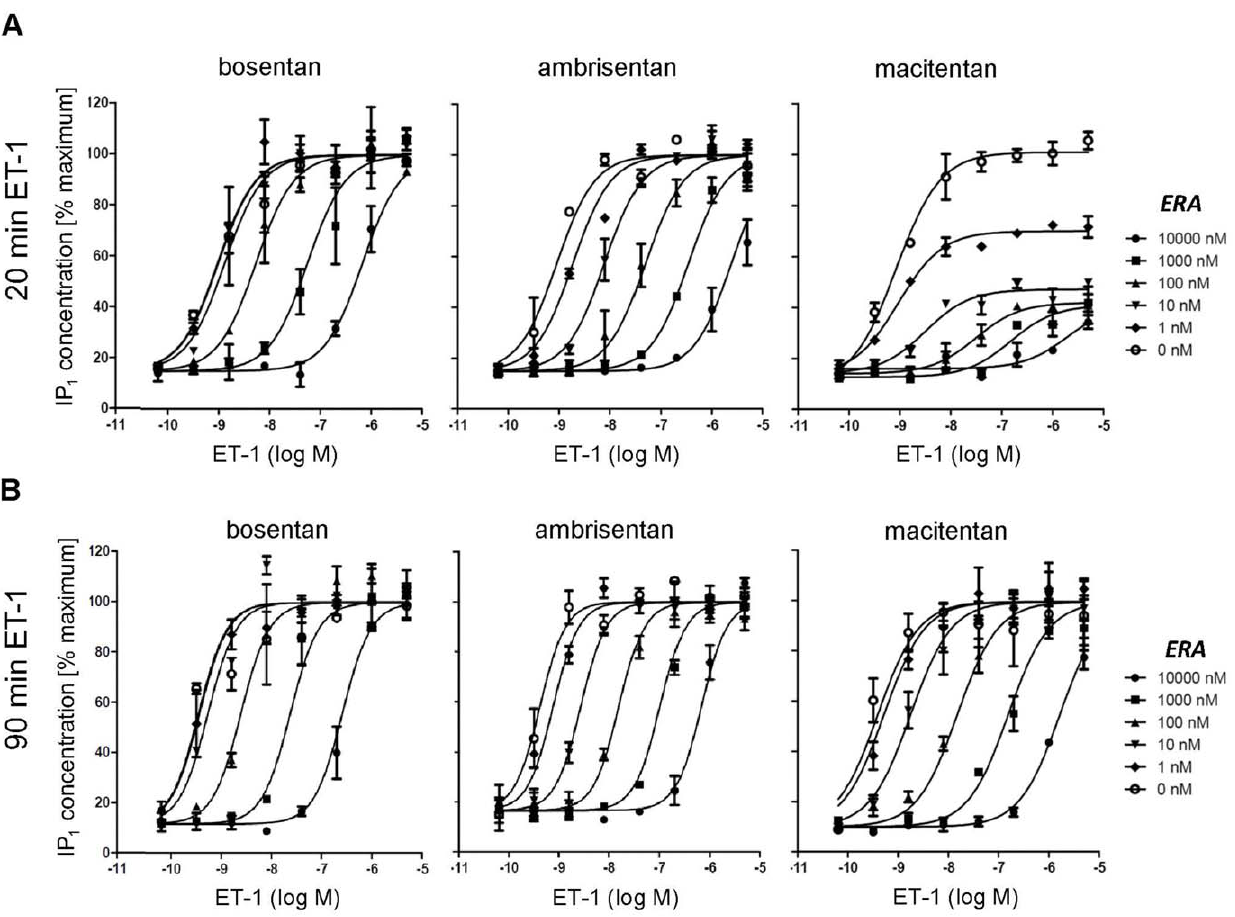
Figure 5. Time dependence of macitentan insurmountability determined in IP 1 accumulation assays. Human PASMCs were pre- incubated with dilution series of antagonists for 120 min followed by the addition of a dilution series of ET-1. After 20 min (A) or 90 min (B) of stimulation, cells were lysed and the IP 1 content was determined. Shown are the raw data + / 2 SD of duplicates of one representative experiment of a total of n=3.